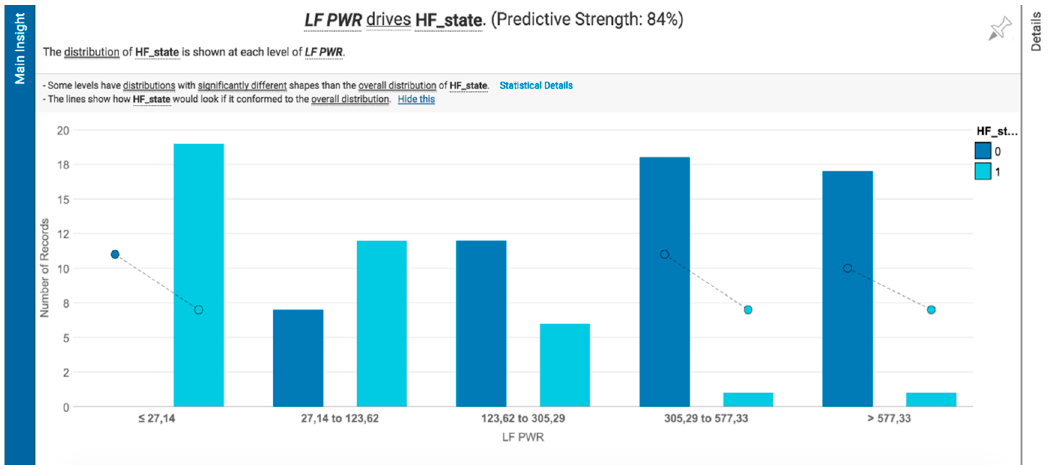
Figure 13. Results for Short Term HRV, using LF_PWR as single predictor.